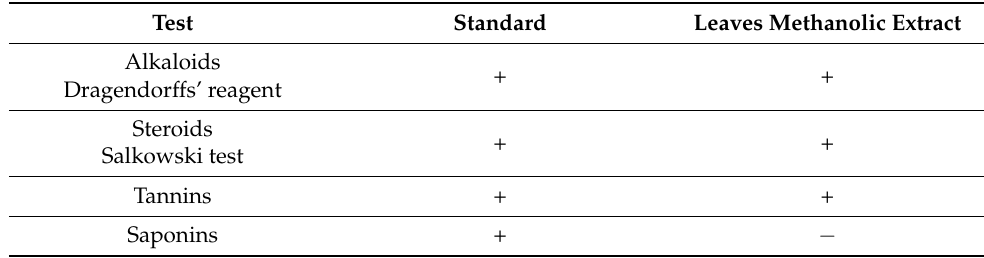
Figure 2. Result of the phytochemical compounds screening of C. hastata leaf methanolic extract. Notes: The “black arrow” shows observed changes in the appearance of the test mixture. Table 1. Phytochemical compounds of C. hastata